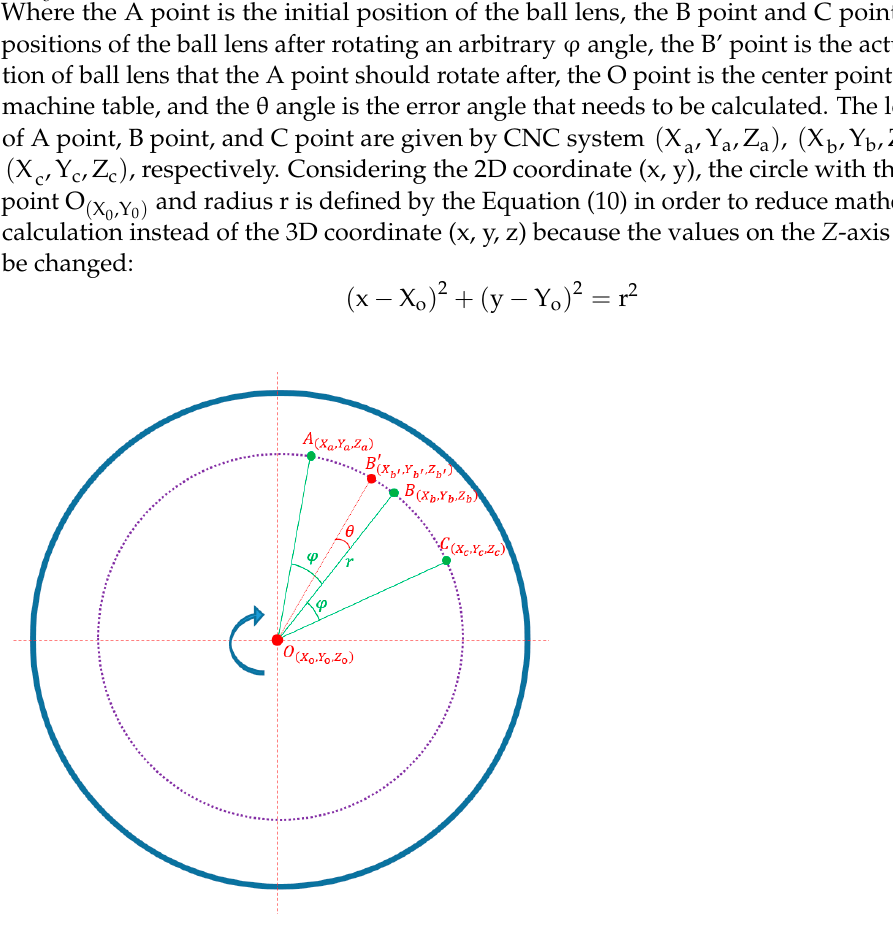
Figure 10. Simply description of the angular error of rotary axis.